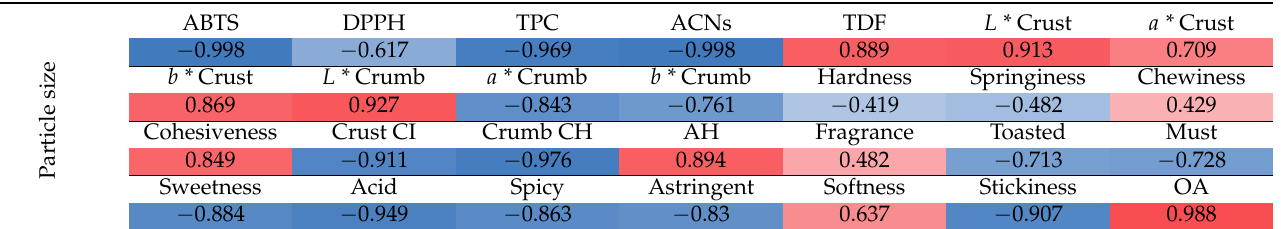
Table 5. Pearson’s correlation coefficients (r) describing association of parameters evaluated and particle